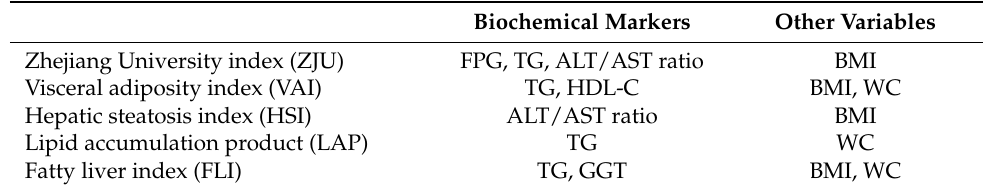
Table 1. The components of common steatosis indices. Biochemical Markers Other Variables Zhejiang University index (ZJU) FPG, TG, ALT/AST ratio BMI Visceral adiposity index (VAI) TG, HDL-C BMI, WC Hepatic steatosis index (HSI) ALT/AST ratio